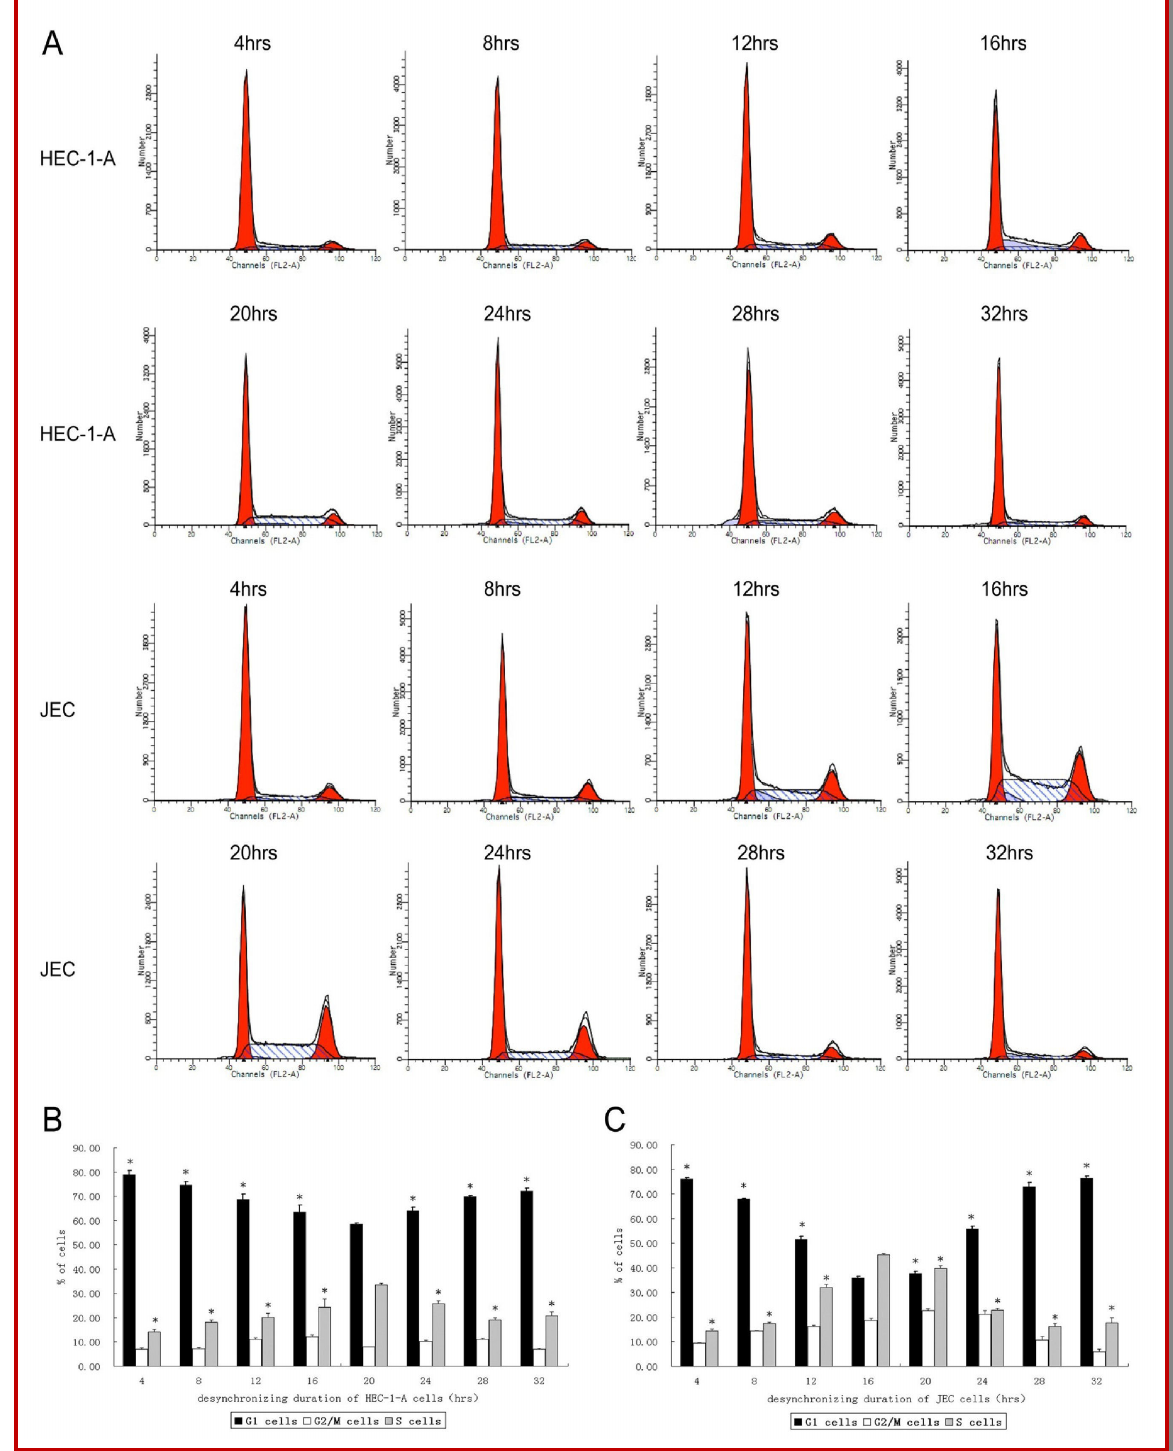
Figure 3: Cell cycle progression after G1-phase desynchronization. (A) Flow cytometric analysis of HEC-1-A cells and JEC cells desynchronized for different durations after induced by optimal lovastatin concentration and duration. (B) Cell cycle progress of HEC-1-A cells desynchronized for different durations after induced by 40 μ mol/L lovastatin for 28 hours. *p<0.05 vs 20 hours (C) Cell cycle progress of JEC cells desynchronized for different durations after induced by 20 μ mol/L lovastatin for 24 hours. *p<0.05 vs 16